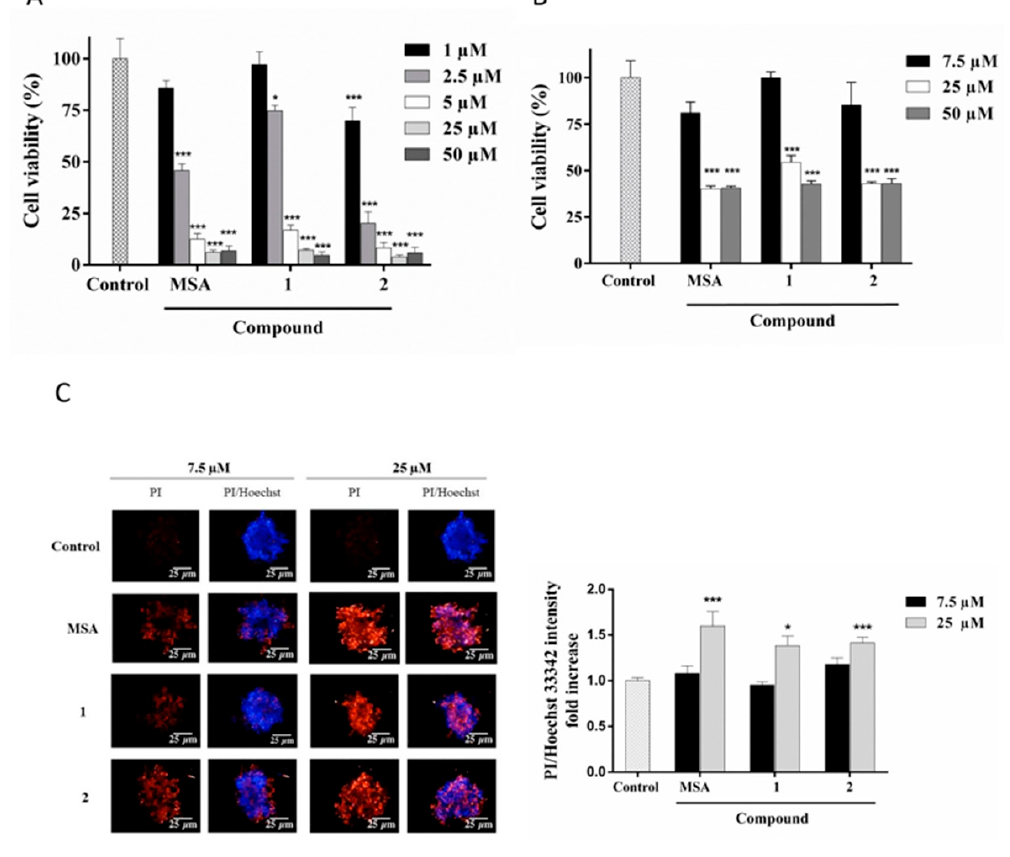
Figure 2. Compounds 1 and 2 and MSA decrease cell viability in 2D and 3D Panc-1 cultures. ( A ) Panc- 1 cells (2D cultures) were treated with different concentrations of the compounds for 72 h followed